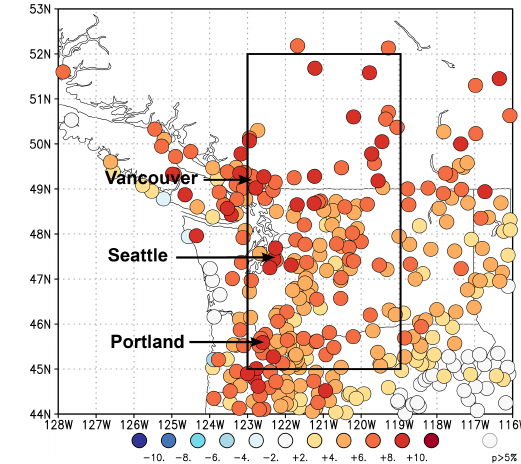
Figure 2. Anomalies of 2021 highest daily maximum tempera- ture (TXx) relative to the mean TXx of the whole time series of each station. The black box indicates the study region. Source: GHCND (Menne et al.,